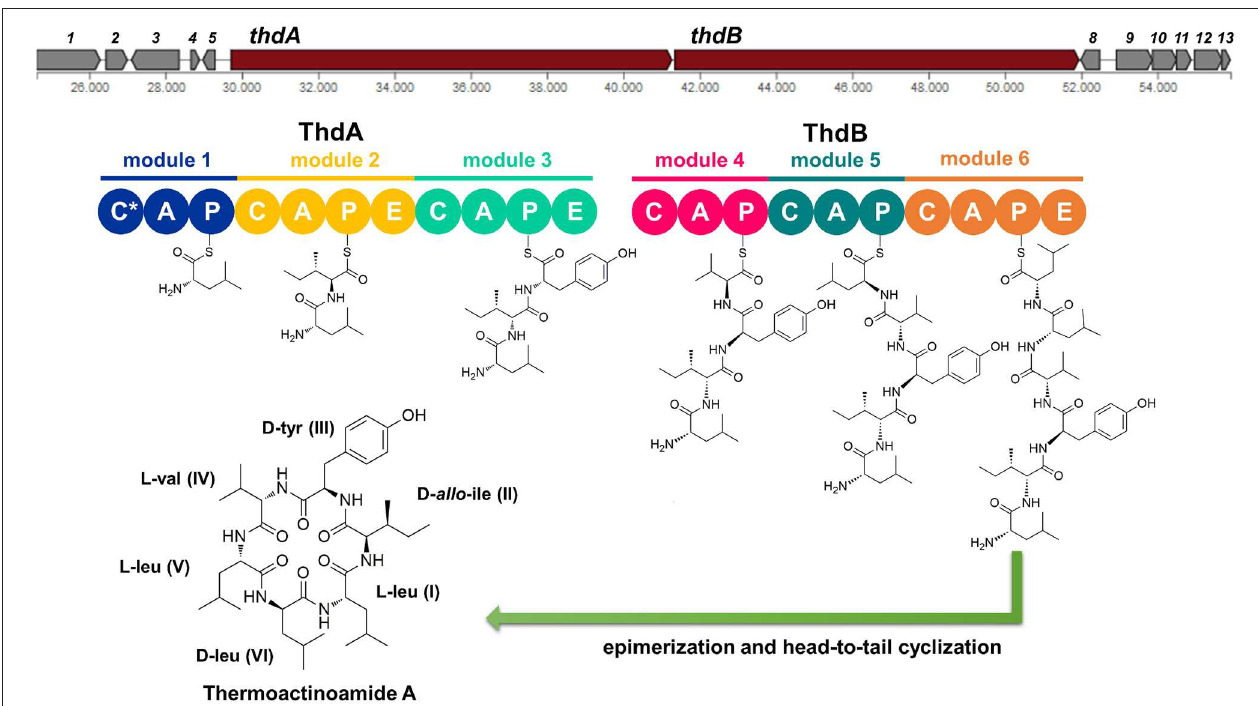
FIGURE 1 | Putative biosynthesis of thermoactinoamide A (abbreviations: C, condensation domain; A, adenylation; P, peptidyl-carrier protein; E, epimerase; C*, truncated condensation domain, probably inactive).